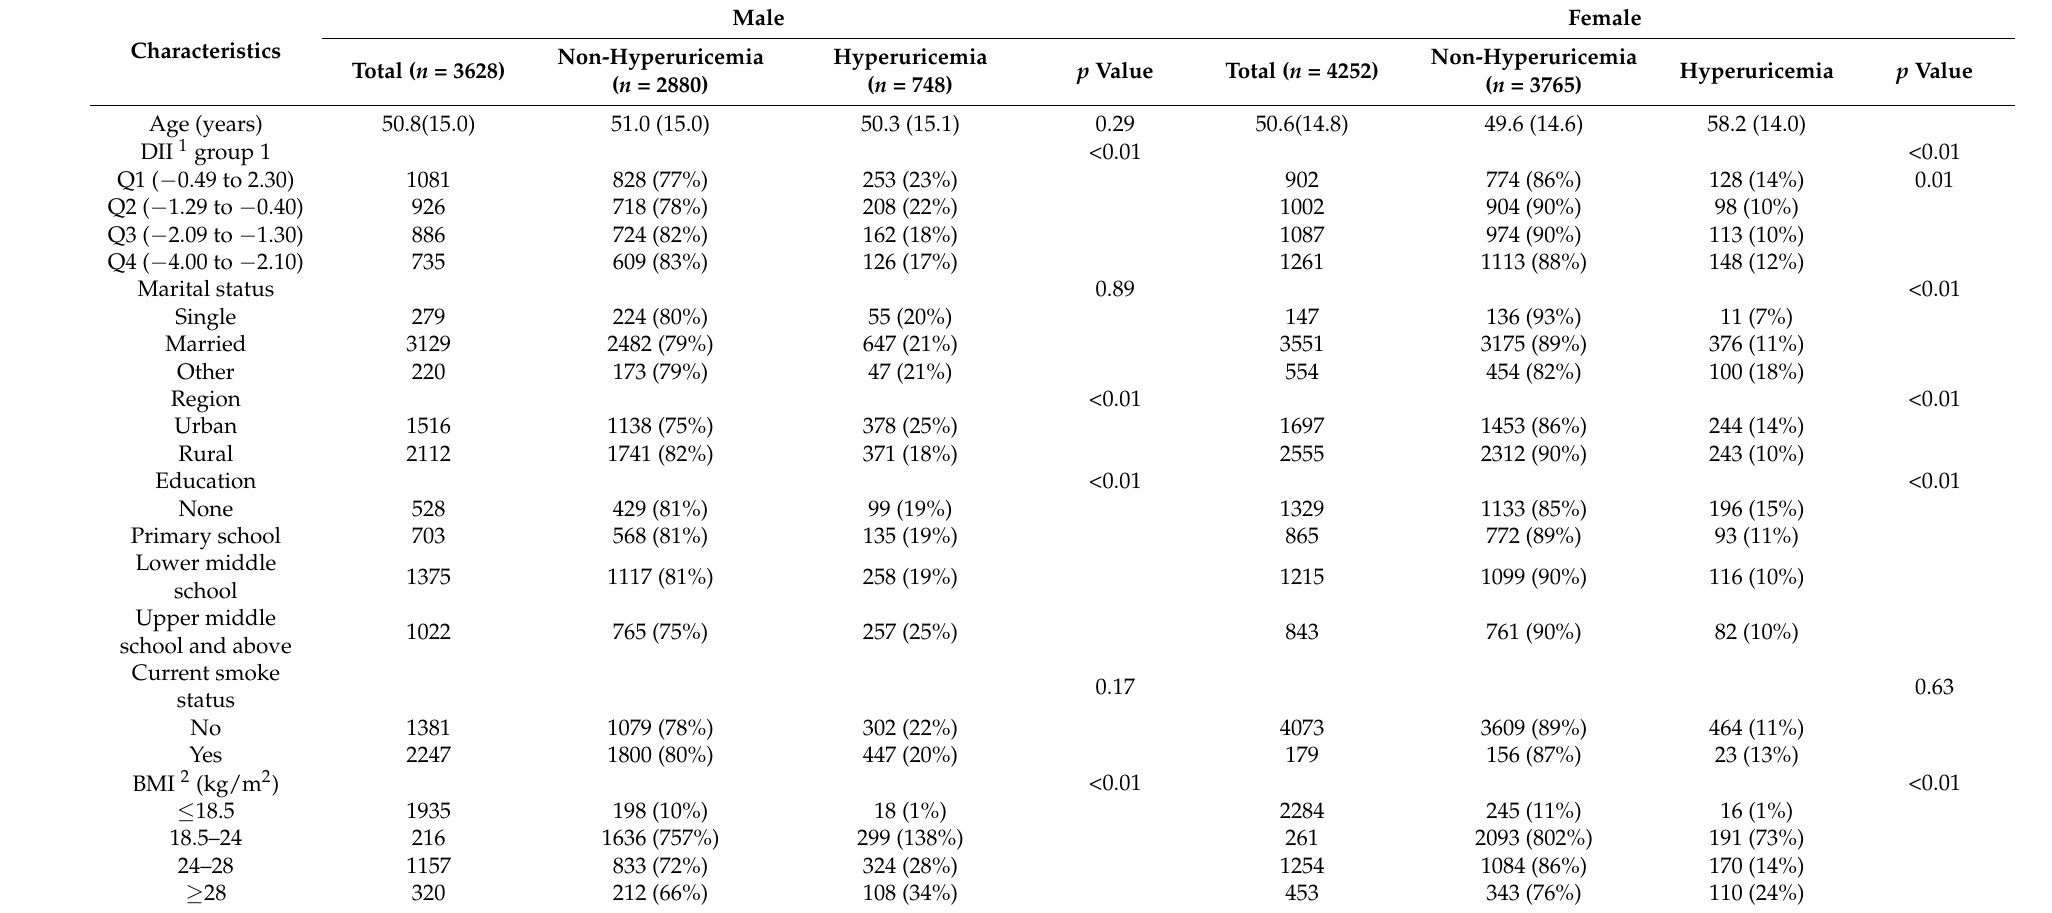
Table 1. Characteristics of subjects according to gender and hyperuricemia